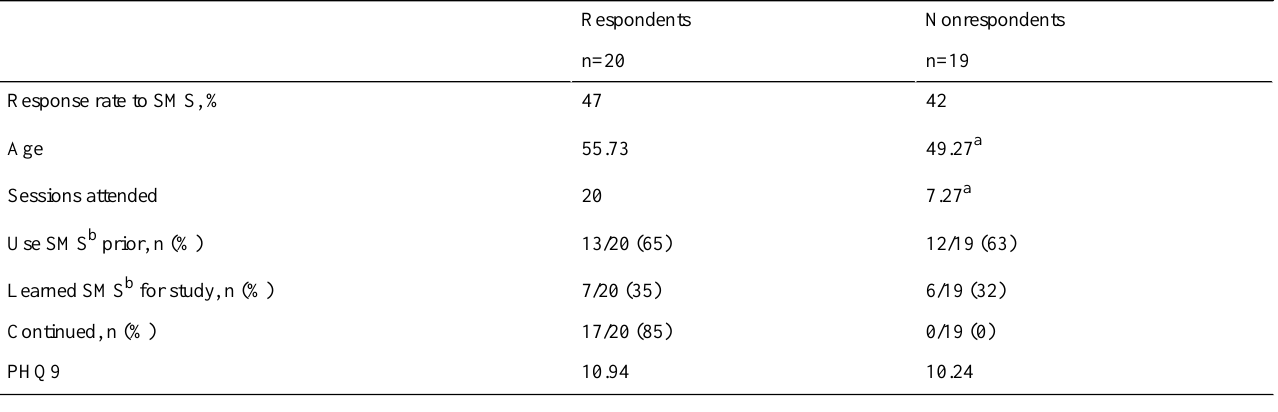
Table 1. Respondent